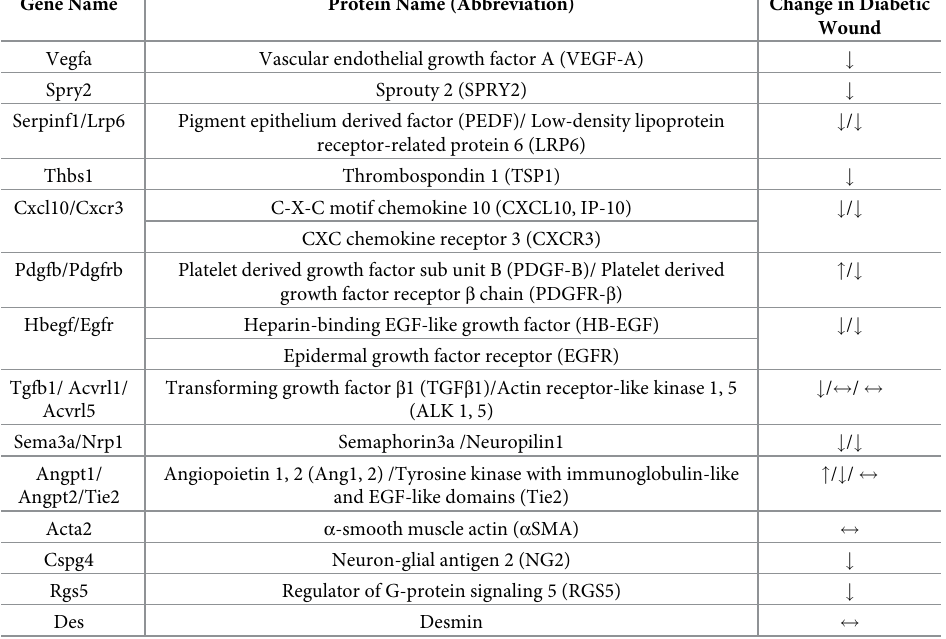
Table 3. Summary of gene expression changes in diabetic wounds as compared to normal